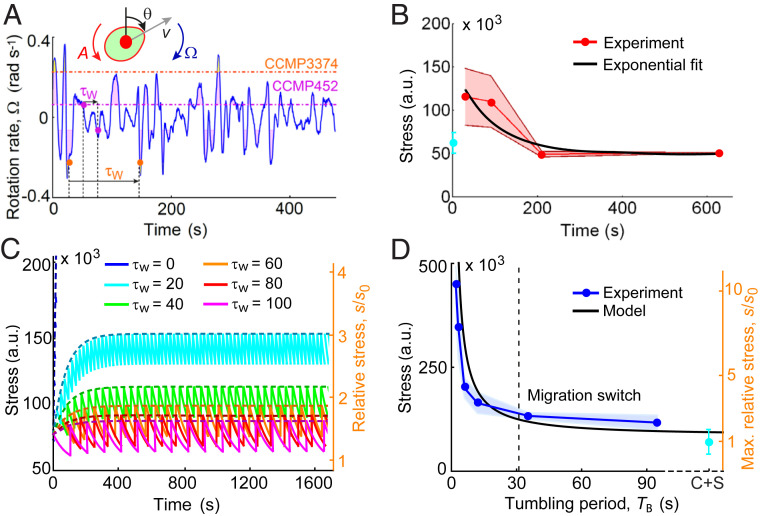
The dynamics of ROS accumulation–dissipation regulate migratory behavior of H. akashiwo. (A) Time series of the rotation rate relative to gravity, Ω, of a passive cell in a 3D isotropic turbulent flow obtained from a direct numerical simulation. Dashed lines represent the value of the stability parameter, A, for CCMP452 (magenta) and CCMP3374 (orange). Shaded regions represent time windows over which a cell will be tumbled by turbulence (i.e., |Ω| > |A|, SI Appendix, Fig. S2A), corresponding in our experiments to imposed reorientations. During times when the rotation rate is |Ω| < |A|, cells are not tumbled but will achieve an equilibrium swimming orientation (SI Appendix, Fig. S1C), corresponding in our experiments to a resting time, τW, between reorientations. The higher mechanical stability of CCMP3374 results in longer resting times (SI Appendix, Fig. S2 B and C). (B) The stress dissipation dynamics, measured in still conditions (red, mean ± SD of four replicates) for a population previously exposed to 5 min of rolling (Ω = 1 rad · s−1), is characterized by an exponential decay with timescale τS = 87 ± 32 s (black). (C) Time series of stress (Eqs. 3 and 4, Materials and Methods) predicted by the mathematical model for the same range of resting times investigated experimentally (Fig. 1F). Cells rapidly accumulate stress after being reoriented (Ω = 3.14 rad · s−1) and dissipate it with timescale τS. The dashed curves represent the upper envelope of the stress signal (SI Appendix, Eq. S6). Stress values have been also normalized by the baseline stress level, s0 = 42 × 103 a.u., for a population under still conditions (orange y axis). (D) Stress caused by intracellular ROS accumulation in a population exposed to rolling as a function of the tumbling period, which is set by the rotation rate through the expression TB = 2π (Ω2 – A2)−1/2, with A = 0.09 rad · s−1 the stability parameter of CMMP452. Stress data are taken from Fig. 2B for the subpopulation of cells that undertake the switch in the direction of migration. The black line shows the predicted maximum stress after rolling (SI Appendix, Eq. S5). The vertical dashed line corresponds to the tumbling period TB = 32 ± 13 s at which the threshold value for the migration switch (SI Appendix, Fig. S8A), h = 2.3 ± 0.6 (relative stress s/s0, orange y axis), is reached. The value of the stress spike generated at each tumbling event is a fitting parameter of the model, Δs/s0 = 0.40 ± 0.07. The cyan dot (C + S) represents the control in which cells were treated with the fluorescent stain CM-H2DCFDA.